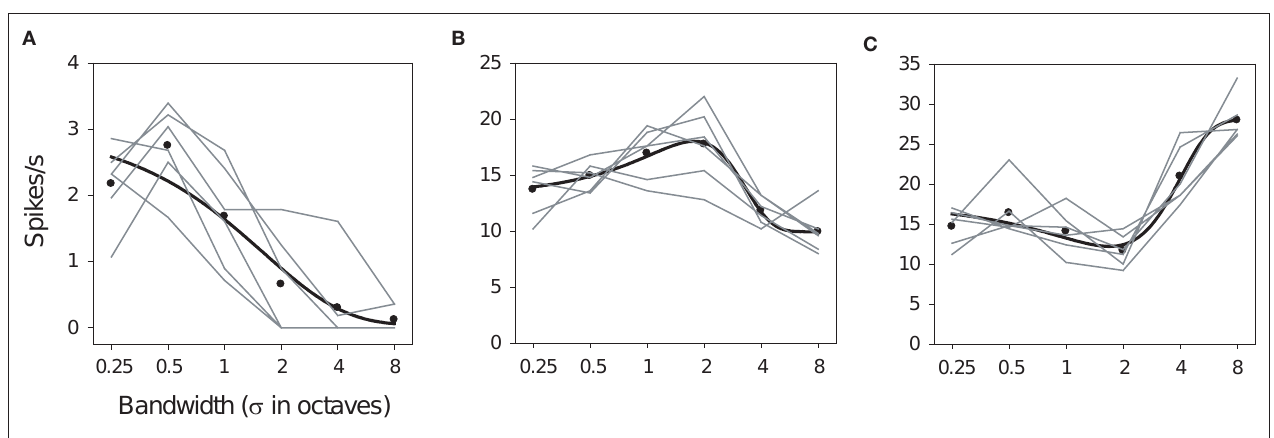
FiGure 6 | Bandwidth tuning. Examples of (A) narrow-band preference, (B) mid-bandwidth preference, and (C) bandwidth reject. The — are best fitting functions as described in Figures 3 and 4